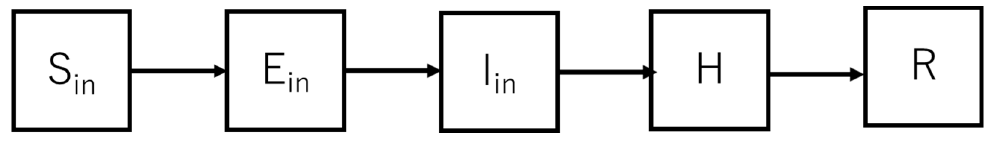
Figure 3. Infection flow diagram in hospital.